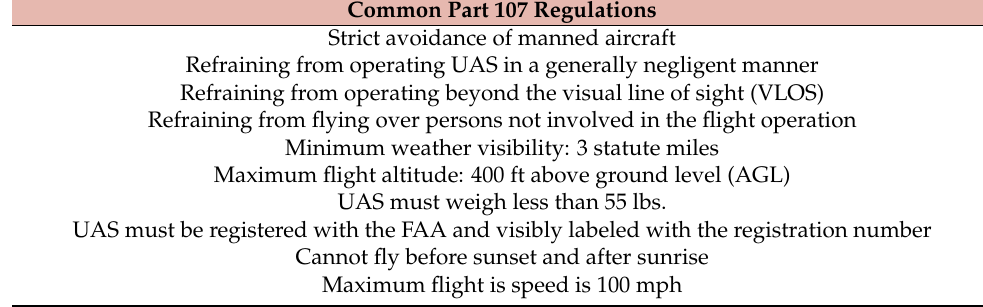
Table 3. Common Part 107